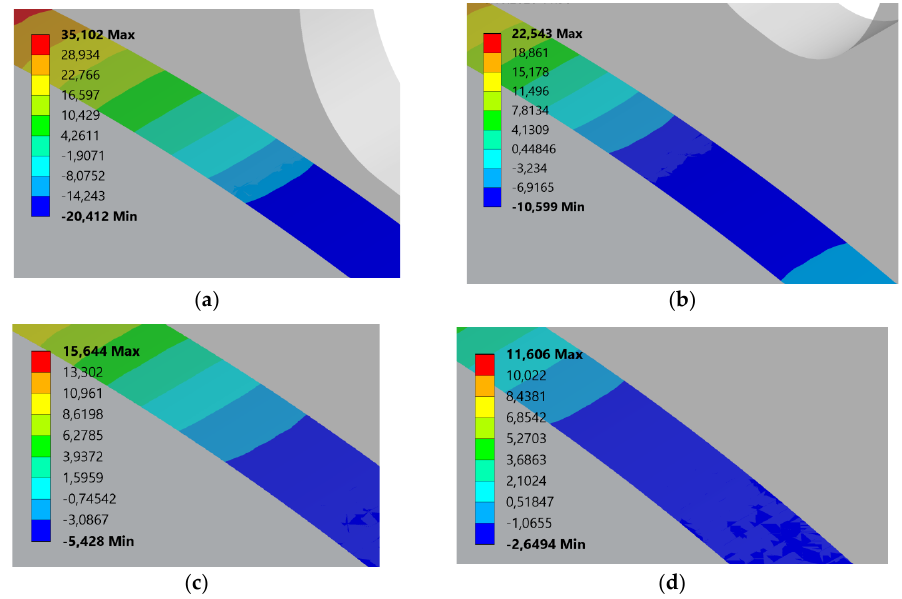
Figure 19. Normal stress results for hybrid gears with α d = 25° for different RTs; ( a ) 0.5 xm, ( b ) 1 xm, ( c ) 1.5 xm, ( d ) 2 xm .